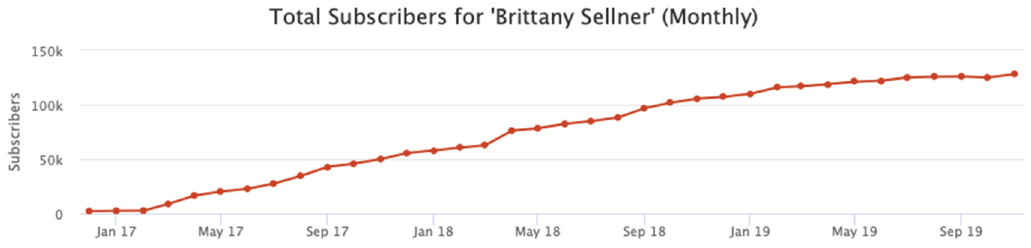
Figure 7. Total YouTube Subscribers Brittany Pettibone.